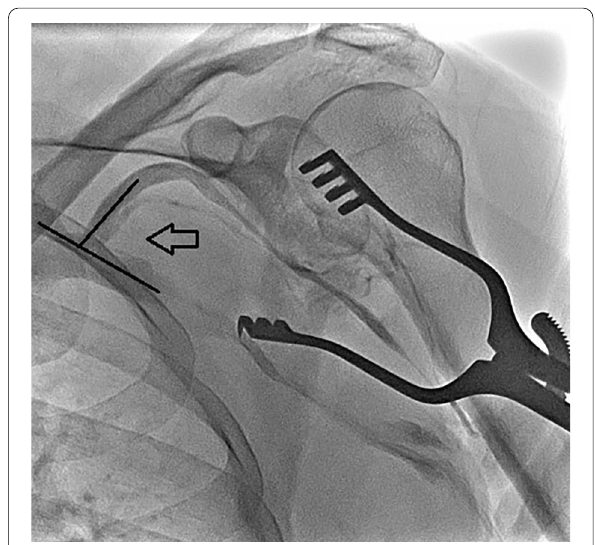
Fig. 2 Black arrow is pointing to the angle of entrance of the cephalic vein into the subclavian vein, drawn with black lines